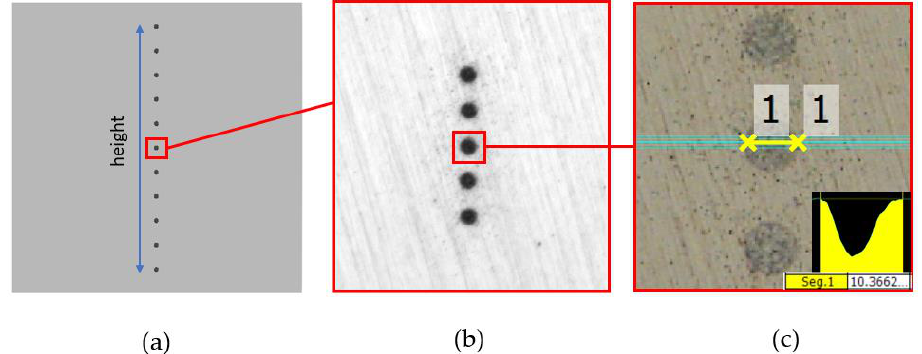
Figure 12. Experiment to investigate the roundness of ablations through camera images and micro- scopic measurements: ( a ) ablation position, ( b ) the number of ablation, and ( c ) ablation measure- ments.